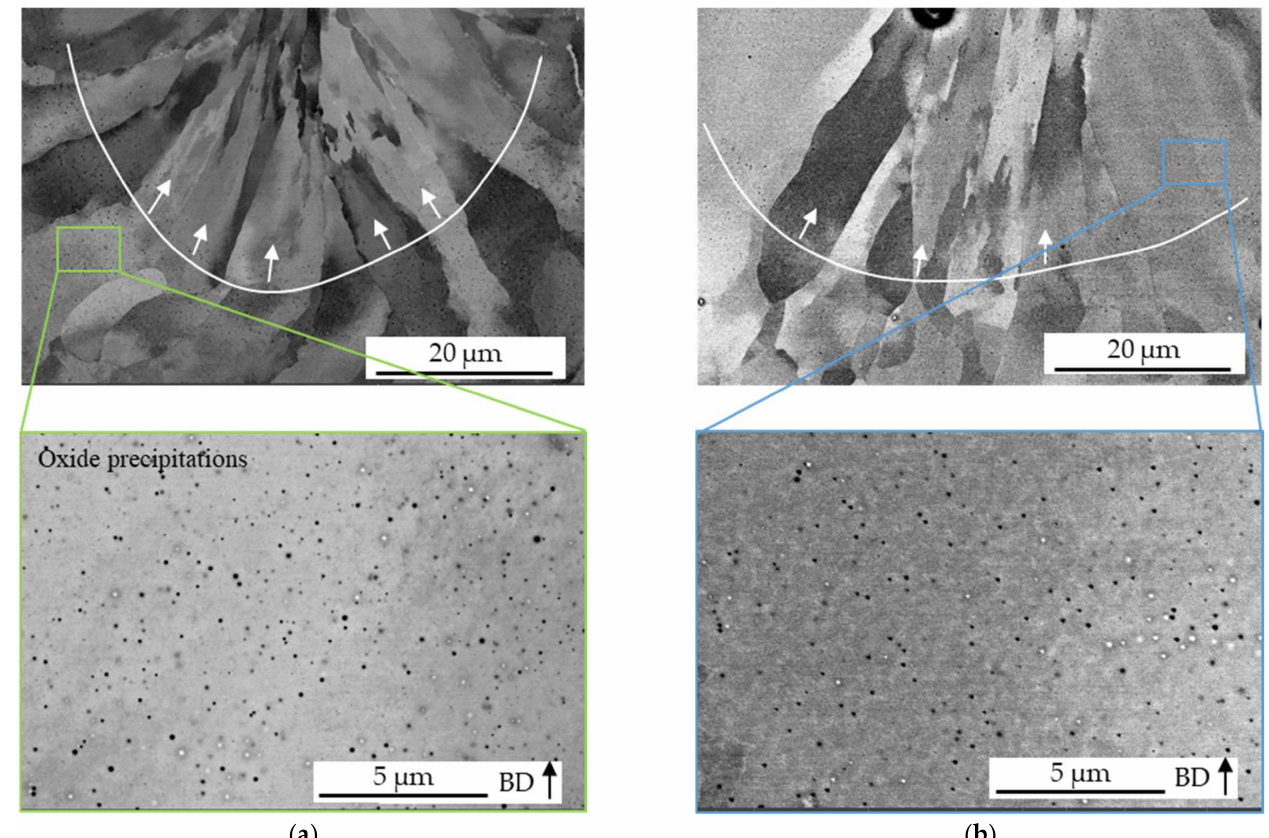
Figure 8. CBS SEM micrographs of single melt tracks of AB L-PBF-processed AISI 318LN under an ( a ) argon atmosphere and ( b ) nitrogen atmosphere. BD: building